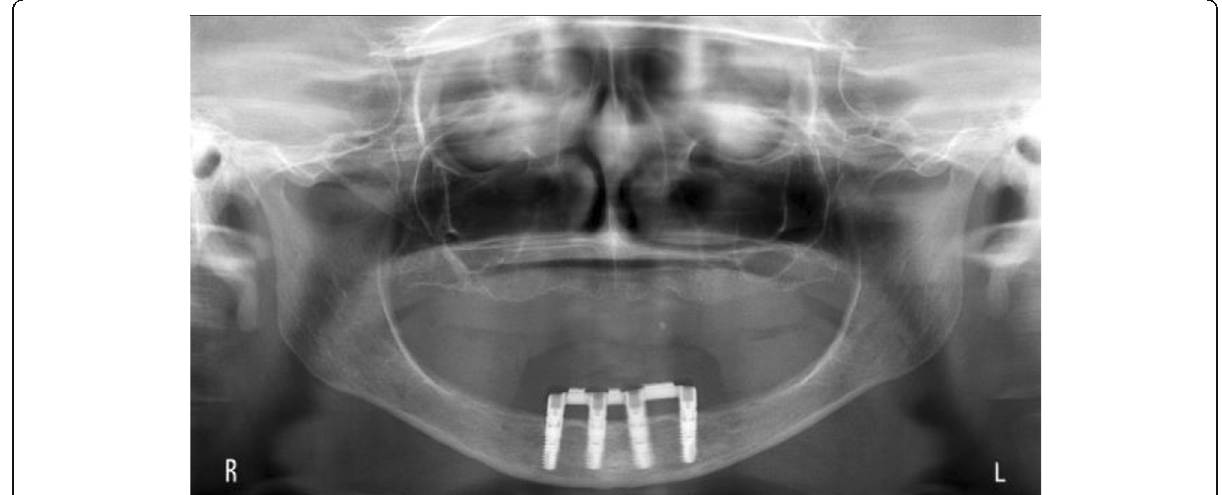
Fig. 4 Rotational panoramic radiograph at the time of the evaluation visit of a patient of the 4-implant